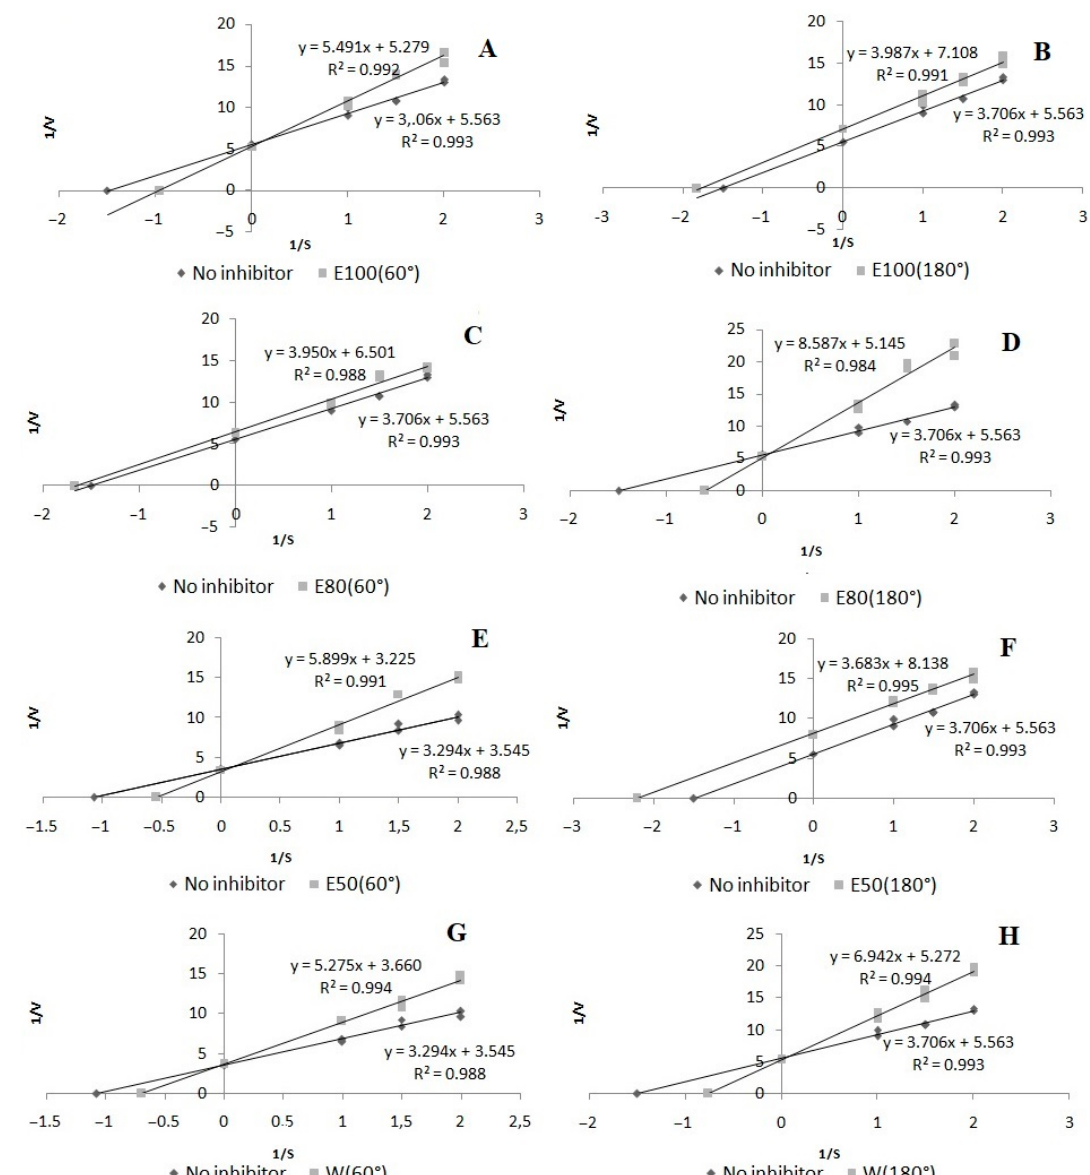
Figure 7. Mode of xanthine oxidase inhibition by extracts from Aerva lanata (L.) Juss.: ( A ) 100% ethanol/60 ◦ C; ( B ) 100% ethanol/180 ◦ C; ( C ) 80% ethanol/60 ◦ C; ( D ) 80% ethanol/180 ◦ C; ( E ) 50% ethanol/60 ◦ C; ( F ) 50% ethanol/180 ◦ C; ( G ) water/60 ◦ C; ( H ) water/180 ◦